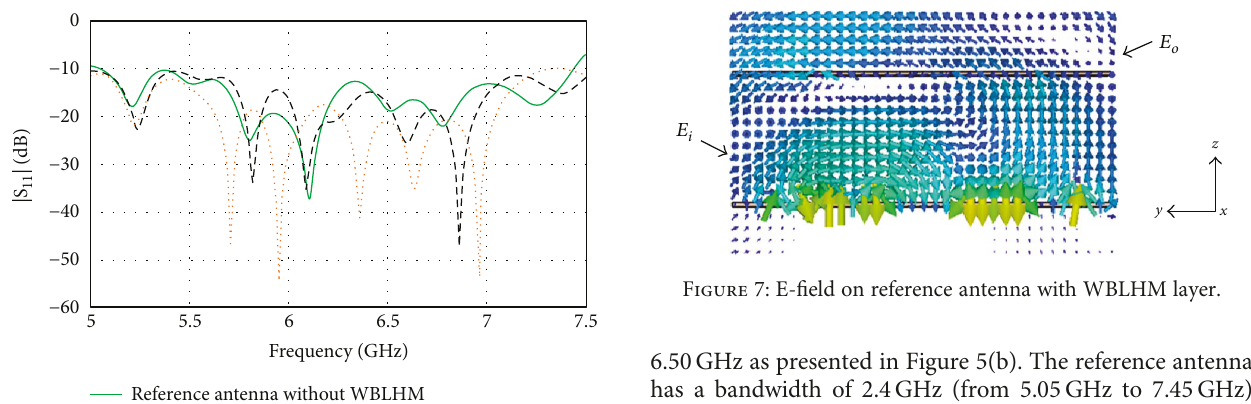
of reference antenna with 11